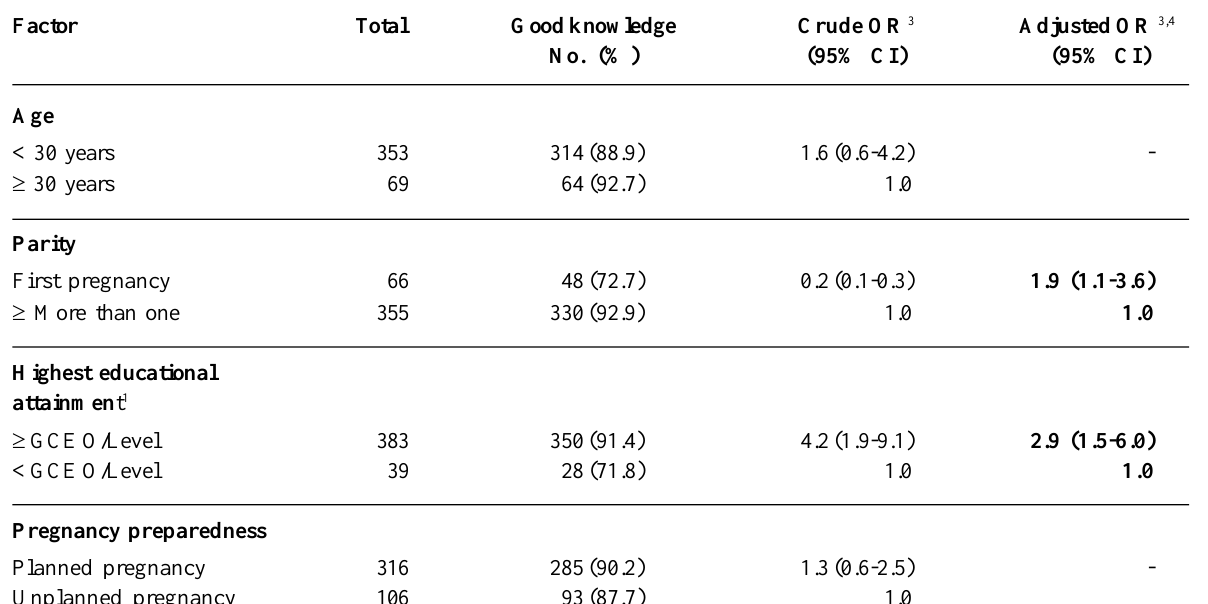
Table 2. Associations between level of knowledge of the study participants on newborn care and selected socio-demographic and pregnancy related